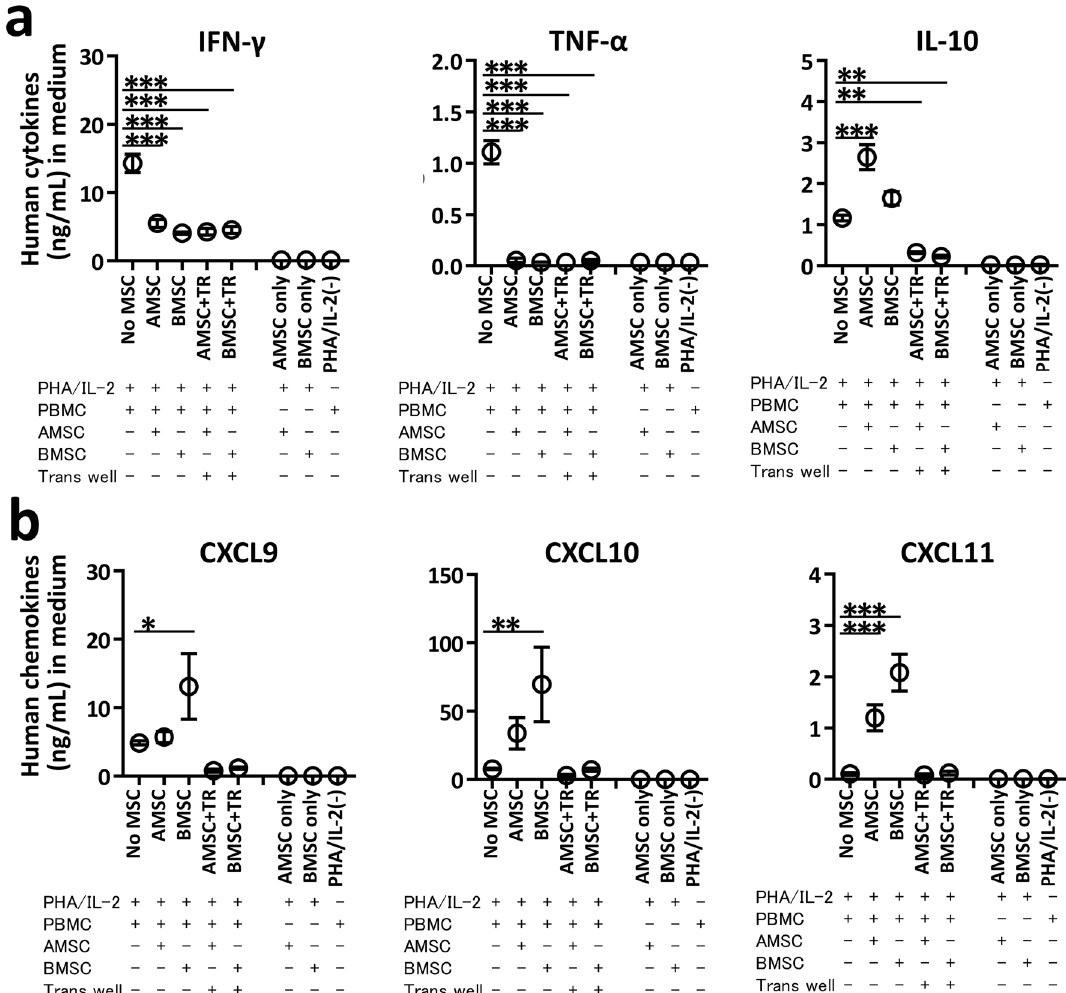
Figure 4. Proinflammatory cytokine and chemokine concentrations in PHA/IL-2 stimulated PBMC in vitro. PBMC were stimulated with 4 μg/mL PHA and 100 U/mL IL-2 for 72 h with or without AMSC or BMSC at a PBMC/MSC ratio of 10:1 ( a , b ). For indirect coculture experiments, a trans well (TR) system comprising upper wells with PBMC and lower wells with MSC was used. Combined data from two or three independent experiments are presented as mean ± SEM. ( a , b ) Concentrations of human cytokines IFN-γ, TNF-α, and IL-10 as well as human chemokines CXCL9, CXCL10, and CXCL11 in culture medium evaluated by multibead-based immunoassay. * P < 0.05, ** P < 0.01, *** P < 0.001 versus No secreted by donor cells were higher in the plasma of patients with acute GVHD, consistent with our observations in xeno-GVHD control mice and mitogen-stimulated PBMC controls in the absence of MSC. However, AMSC treatment did not decrease IFN-γ concentrations in vivo, contrary to that observed for TNF-α concentrations. PD-1 is upregulated on T cells during immune activation 31 . Ahn et al. 32 reported that CD8 + T cells expressed PD-1 early after virus infection, whereas Simonetta et al. 33 demonstrated that population of CD8 + T cells express- ing PD-1 increased early in patients undergoing allo-HSCT. We confirmed that percentage of PD-1 + CD8 + T cell population, which was increased over time in xeno-GVHD control mice (similar to that reported in a clinical study 33 ), was significantly ameliorated by AMSC infusion. Weiss et al. 34 indicated that MSC secrete soluble factors, including prostaglandin E2, indoleamine 2,3-dioxy- genase, transforming growth factor beta 1, galectin-1, IL-6, nitric oxide, and PD-L1, to downregulate effector T cells and monocytes. We showed that AMSC and BMSC inhibited CD3 + T cell proliferation and PD-1 + T cell activation as same levels in vitro regardless of the culture conditions, indicating that contact-independent mechanisms were important. Conversely, Treg population and concentrations of some cytokines and chemokines were changed in direct cocultures versus in indirect cocultures comprising MSC and PBMC. Typical MSC are well-known to induce Treg by several mechanisms including soluble mediator secretion, cell–cell interactions, and APC modulation 35 . Consistent with our results that Treg populations were more increased in direct PBMC–MSC cocultures, English et al. 36 reported that cell–cell contact was more important than soluble factors based on an in vitro Treg induction assay using a transwell system. CXCL9, CXCL10, and CXCL11 are ligands of CXCR3, a T cell-specific chemokine